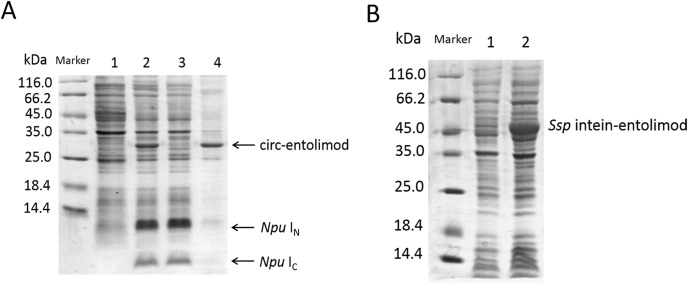
SDS–PAGE analysis of circ-entolimod expression.(A) circ-entolimod is mainly expressed as inclusion bodies. Lane 1: Before induction; Lane 2: circ-entolimod expression after induction with IPTG; Lane 3: Supernatant proteins containing circ-entolimod after sonication; Lane 4: Precipitated proteins containing circ-entolimod after sonication. The two fragments (IN and IC) of Npu intein are clearly seen in Lane 2 and 3. (B) Ssp intein in mediating entolimod cyclization. Lane 1: Before induction; Lane 2:Precursor protein Ssp intein-entolimod after induction with IPTG.